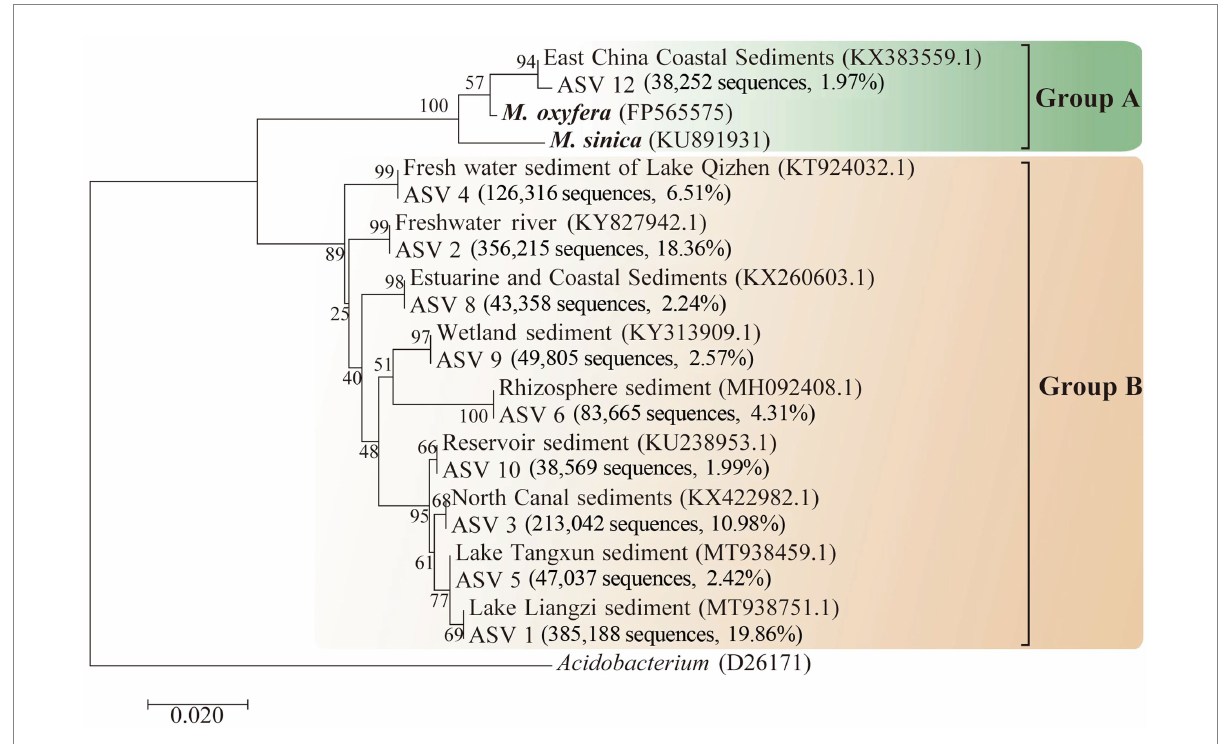
FIGURE 1 Neighbor-joining phylogenetic tree showing the phylogenetic affiliations of denitrifying anaerobic methane oxidation (DAMO) bacteria. Bootstrap values were calculated by 1,000 replicates, and the scale bar represented 2% sequence